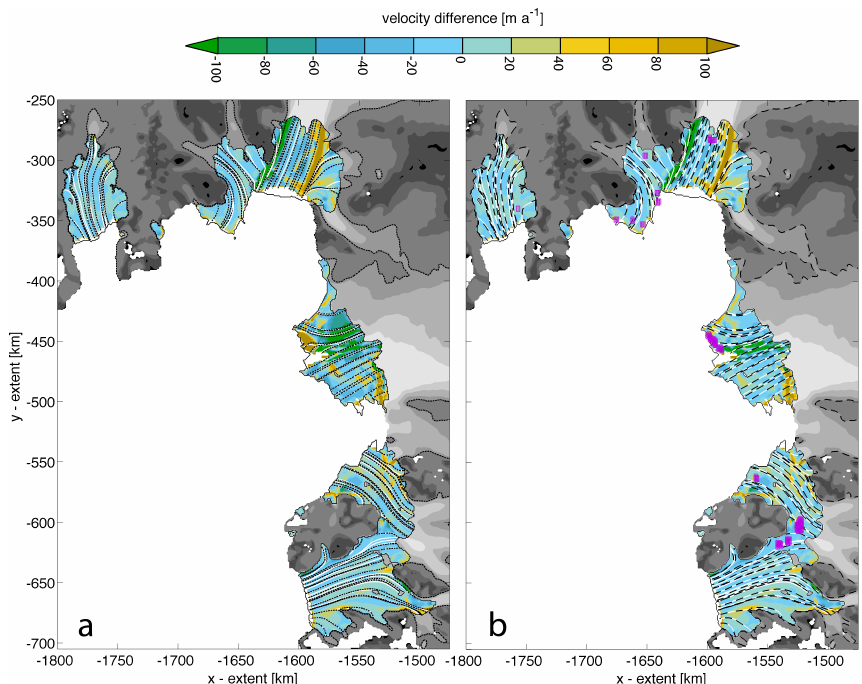
Figure 5. Velocity differences as in Fig. 4 for the ice shelves in the Amundsen Sea embayment. Results are based on the T geometry for the cases that complementary information on pinning points (pink rectangles, PIN5) is not accounted for (a) or accounted for (b) in the inversion. Shading, contour lines and markers as in Fig.